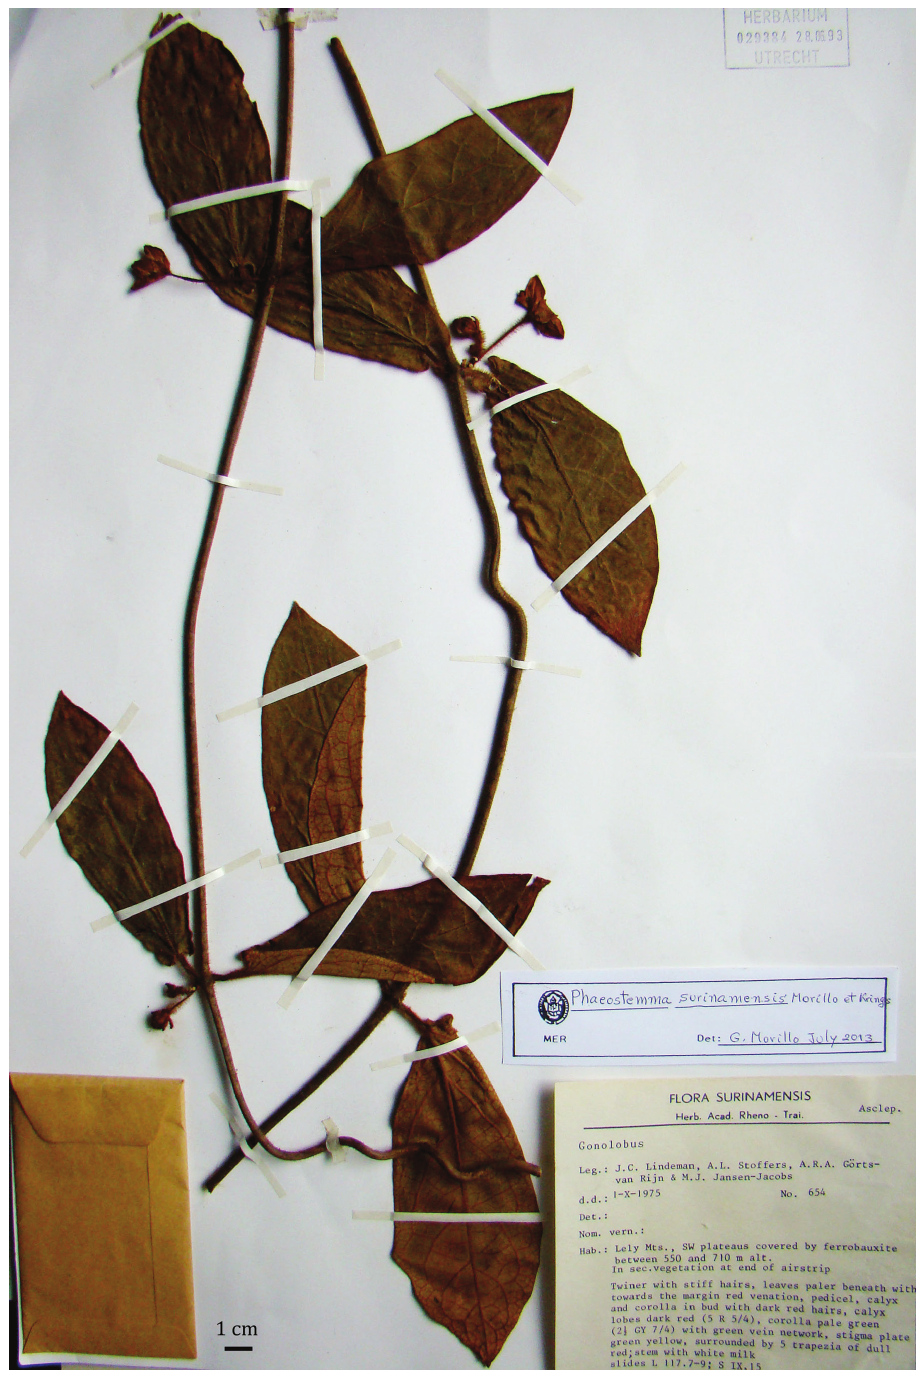
Figure 4. Holotype of Phaeostemma surinamensis ( Lindeman et al. 654 ,